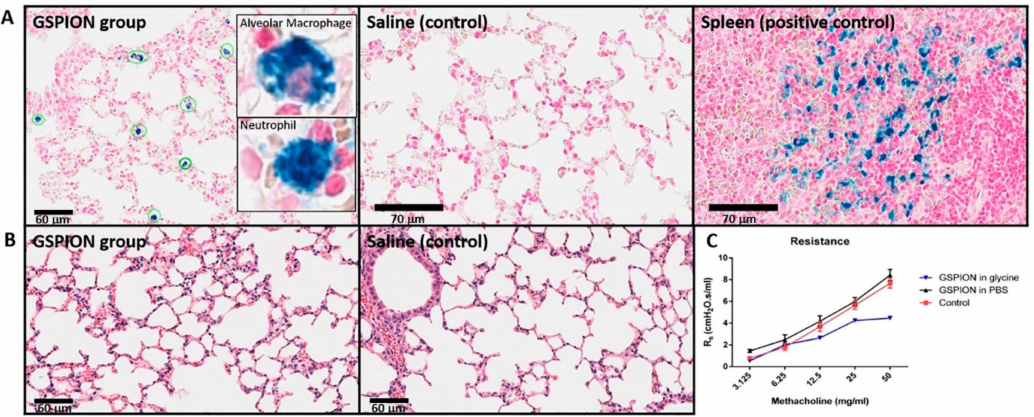
Figure 3. The therapeutic ability of GSPIONS to alleviate lung resistance was not directly tested, although their localization into immune cells suggests this potential. ( A ). Perls’ Prussian blue counter stained with neutral red to determine uptake by immune cells in the lung for GSPIONs and saline group and spleen showing positive stain due to hemosiderin. ( inset ) GSPIONs taken up by alveolar macrophages and neutrophils confirmed by nucleus visible after Perls’ Prussian blue counter stained with neutral red. ( B ). Hematoxylin and Eosin stain showing lung parenchyma in both GSPION and saline (control) group. ( C ). Lung resistance measured by invasive plethysmography in GSPIONs suspended in glycine and PBS in comparison to control. No significant di ff erence was observed in between control and GSPION